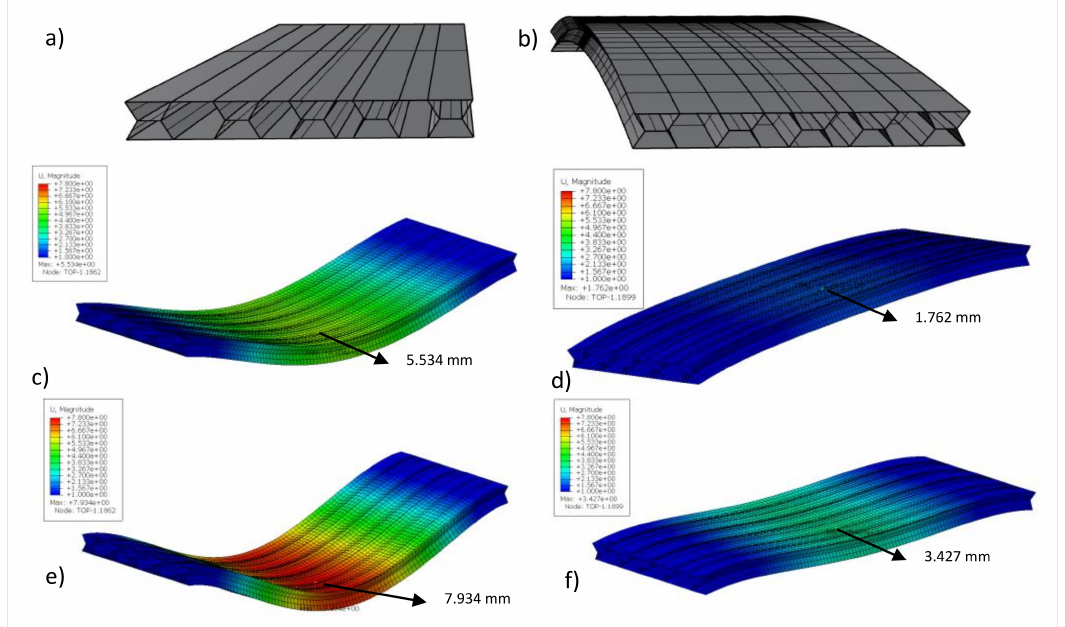
Figure 5. Geometry of: ( a ) Superdeck and ( b ) Superdeck in an arch. Deformation for: ( c ) Superdeck (laminate); ( d ) Superdeck (laminate) in an arch; ( e ) Superdeck (quasi-isotropic); ( f ) Superdeck (quasi-isotropic) in an arch.